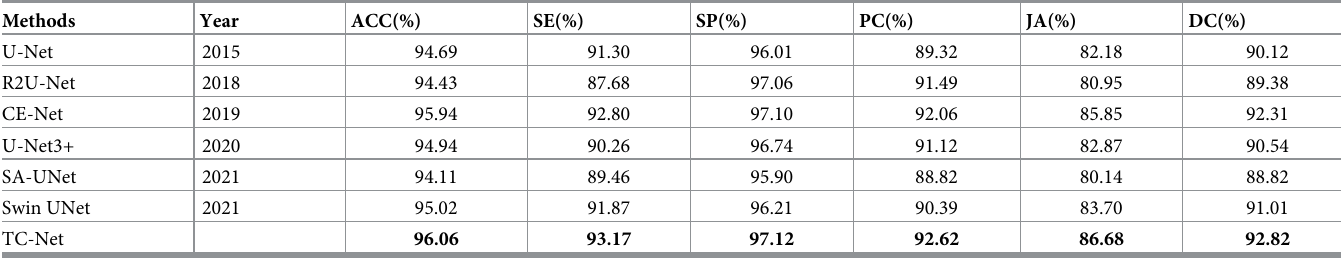
Table 6. Comparative experiments based on ISBI2016